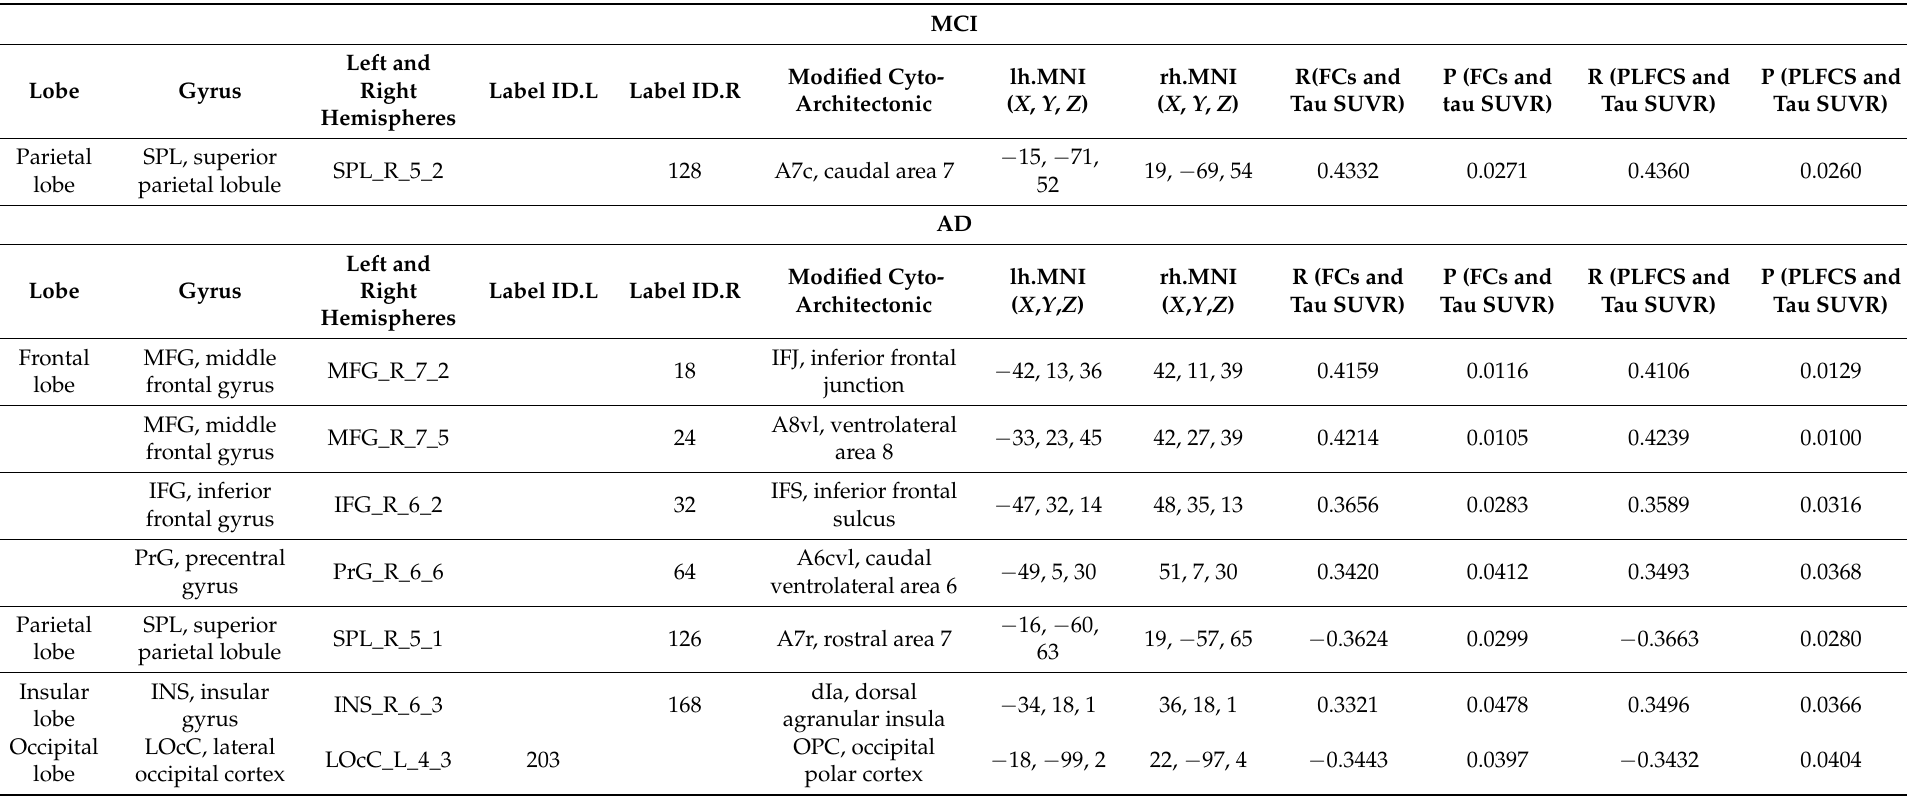
Table 2. Brain regions with significant correlation of FCs/PLFCS and tau